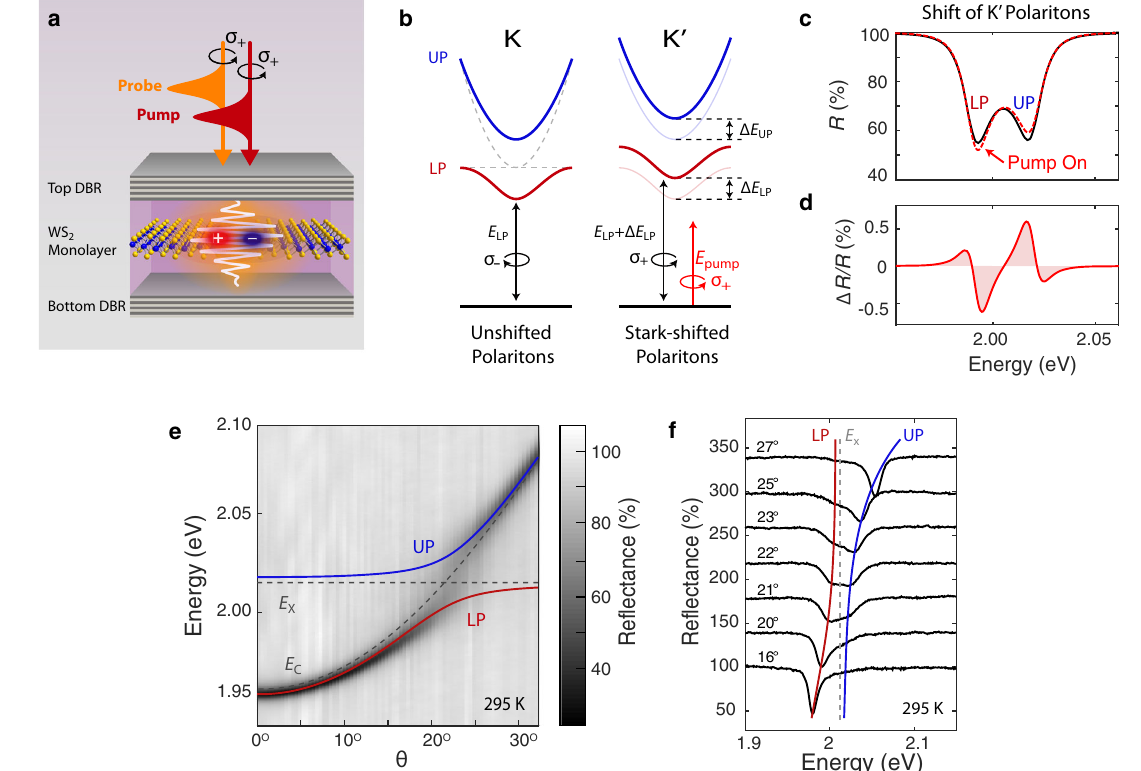
Fig. 1 The valley-selective optical Stark effect in TMD microcavity exciton-polaritons. a Cartoon of the polarization-dependent transient re fl ectance measurement of WS 2 polaritons in a monolithic cavity. b Schematic of valley-selective optical Stark shift for polariton energy dispersions. Polaritons at the K and K ′ valleys couple to left-handed ( σ − ) and right-handed ( σ + ) circularly-polarized light, respectively. The σ + polarized, below-bandgap pump only couples to polaritons in the K ′ valley, inducing an optical Stark shift of both the upper ( Δ E UP ) and lower ( Δ E LP ) polariton energies in just this one valley. c Calculated change in microcavity re fl ectance R for polaritons in the K ′ valley due to σ + -polarized pump pulse. The K valley polaritons should experience no change in re fl ectance. d Expected differential re fl ectance spectrum Δ R / R induced by the pump, showing the characteristic lineshape of the polaritonic optical Stark effect. e Momentum-space re fl ectance spectrum obtained by angle-resolved spectroscopy showing an avoided crossing when the cavity mode energy E C is resonant with the TMD exciton energy E X . f Cross sectional re fl ectance data from e at various angles (offset for clarity). Both e and f show UP and LP branch dispersions in blue and red coinciding with the spectral peak energies.